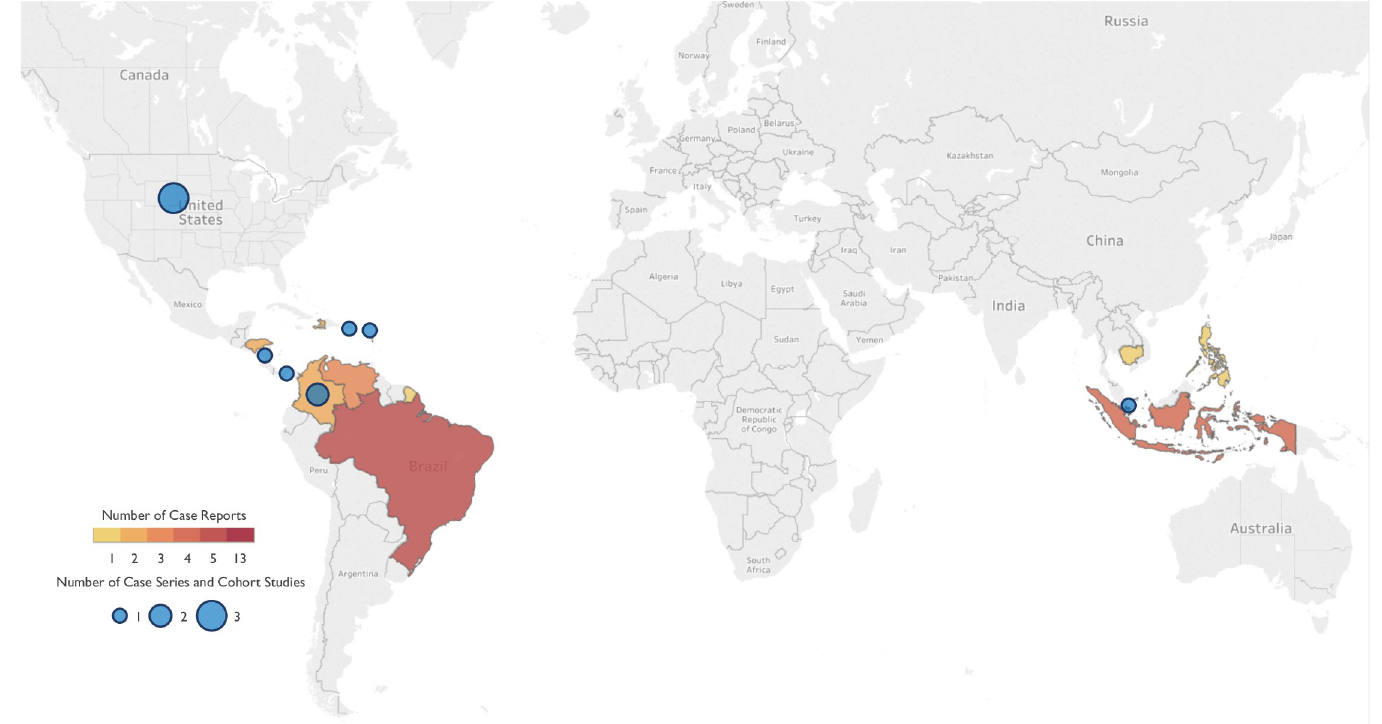
Fig 1. World map displaying the location of the 32 studies included in the systematic review. For studies reporting on travel-associated infections, the country of infection was reported as location of study. Dark red indicates the countries with the greatest representation of case reports. Size of blue circle indicates the number of cohort and case series studies within a given